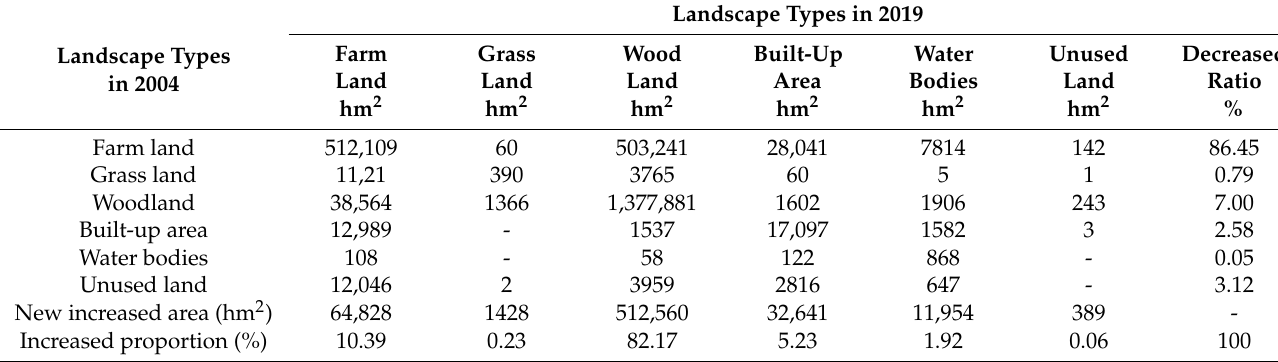
Table 6. Landscape type area transition matrix from 2004 to 2019.